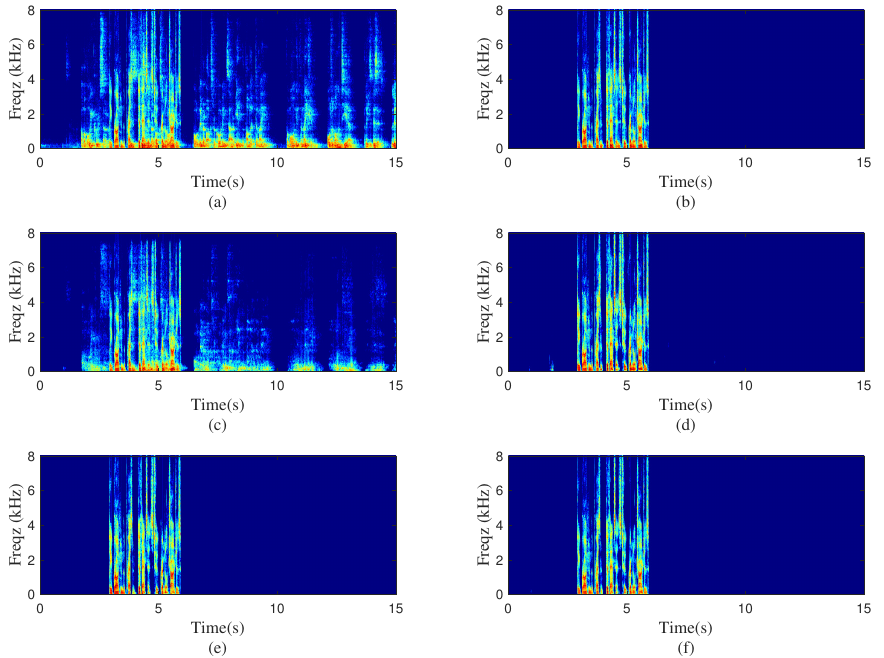
Figure 5. Spectrograms processed by different methods with standard loudspeakers layout. ( a ) Mi- crophone signal, PESQ = 2.42, ( b ) clean near-end speech, ( c ) PBFDLMS algorithm, ERLE = 15.04 dB, PESQ = 2.74, ( d ) D-format model-based algorithm, ERLE = 41.92 dB, PESQ = 3.01, ( e ) Singlechn model-based algorithm, ERLE = 56.21 dB, PESQ = 2.84, ( f ) B-format model-based algorithm, ERLE = 58.38 dB, PESQ = 2.98.